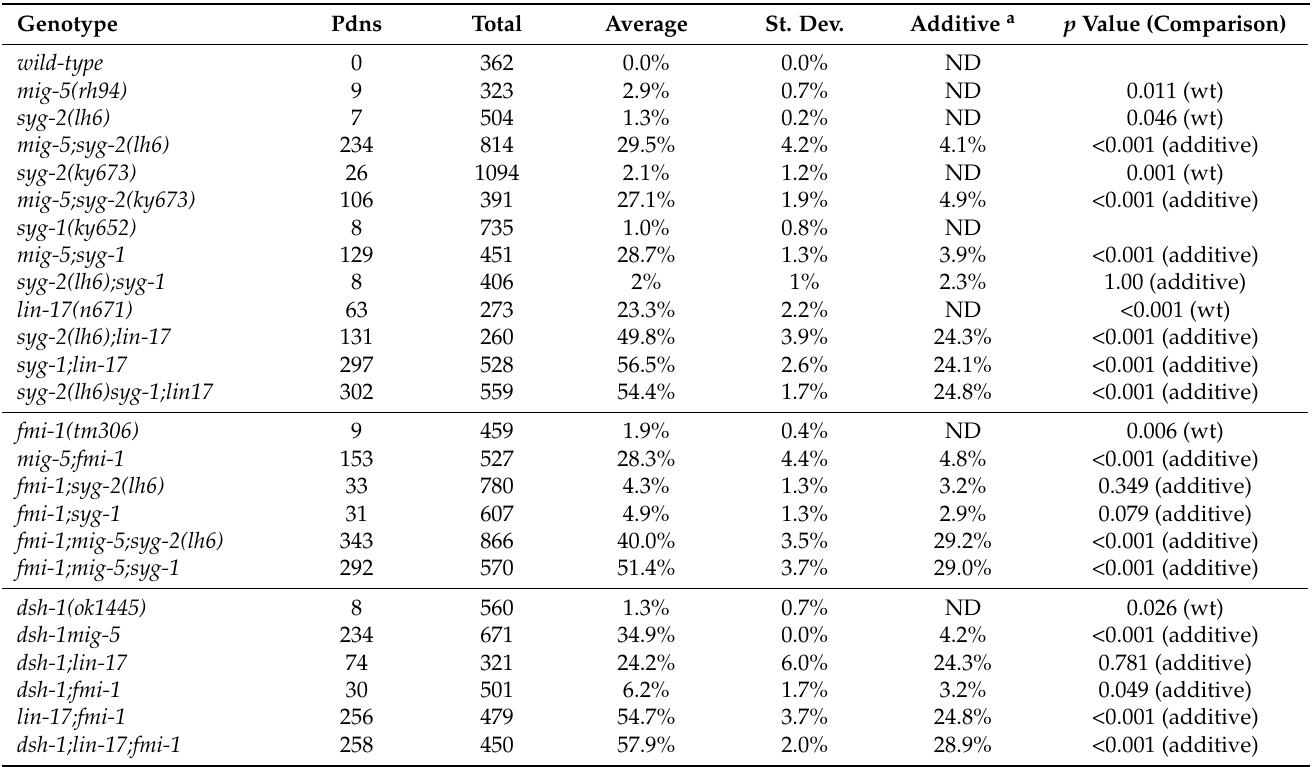
Table 1. Pdns observed in adults (DDs and